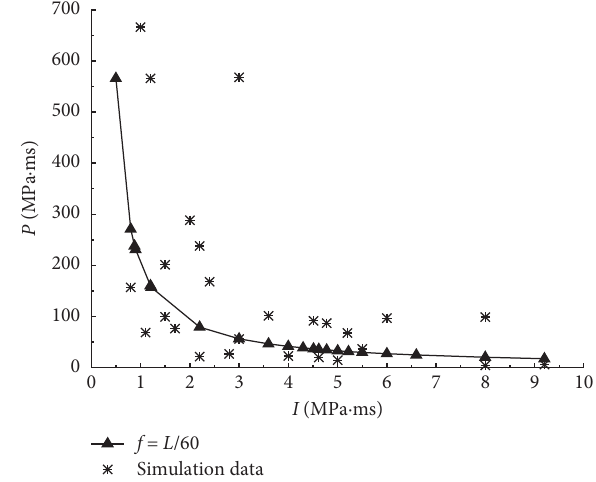
Figure 20: Pressure-impulse (P-I) curve of the NSS CFST